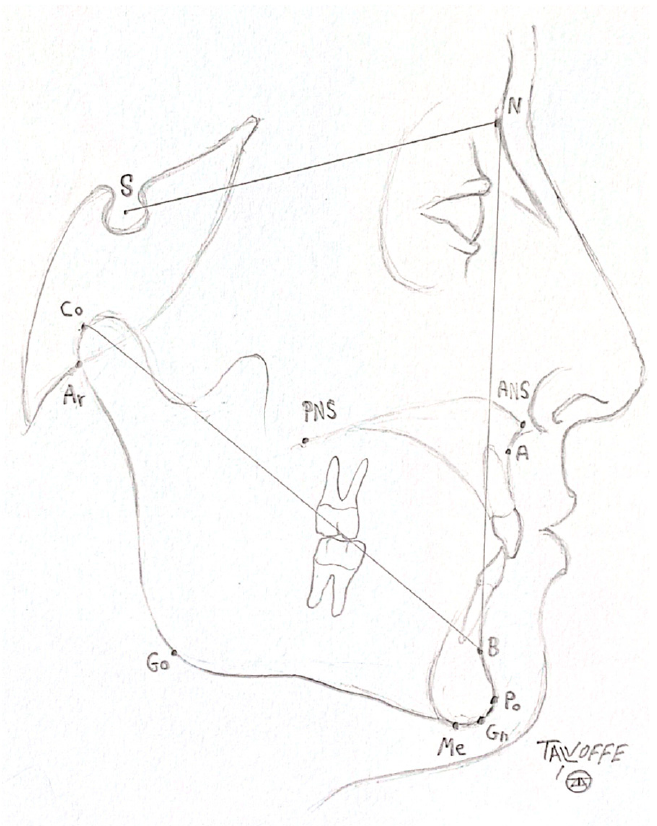
Figure 1. Lateral cephalometric X-ray measuring points. Abbreviations: S—Sella; N—Nasion; A—Hard tissue A point; B—Hard tissue B point; Co—Condylion.